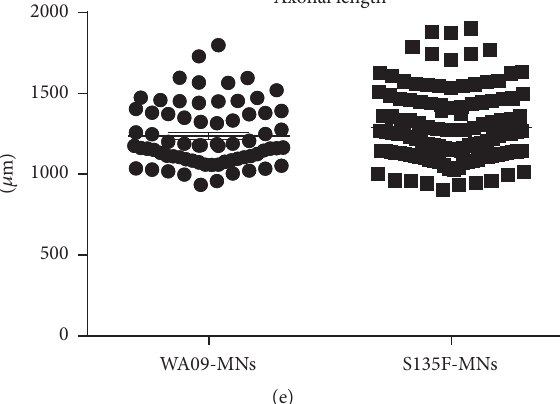
Figure 2: Generation of CMT2F-specific in vitro model by differentiation of patient-derived iPSCs into MNs. (a) Schematic presentation of MN differentiation. (b) Differentiated MNs showed typical cellular morphology (original magnification, 50x). Scale bars: 200 𝜇 m. (c)